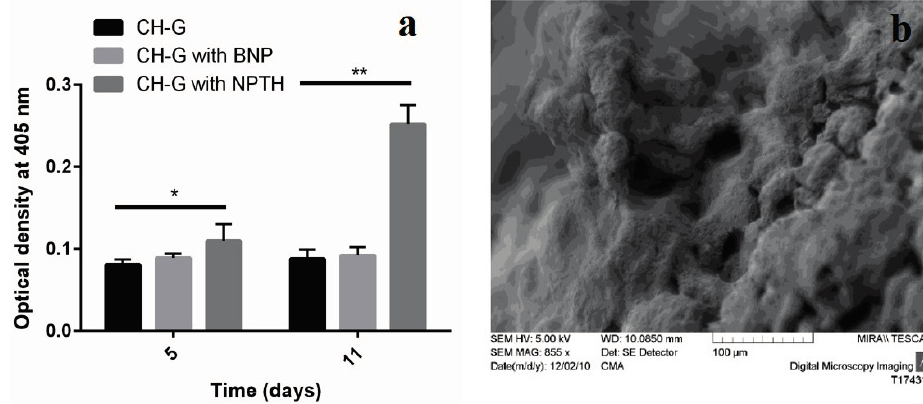
Figure 12. ( a ) ALP levels expressed on scaffolds; ( b ) SEM image representing bio-mineralization on NPTH engrafted scaffolds 11 days of post cell seeding.